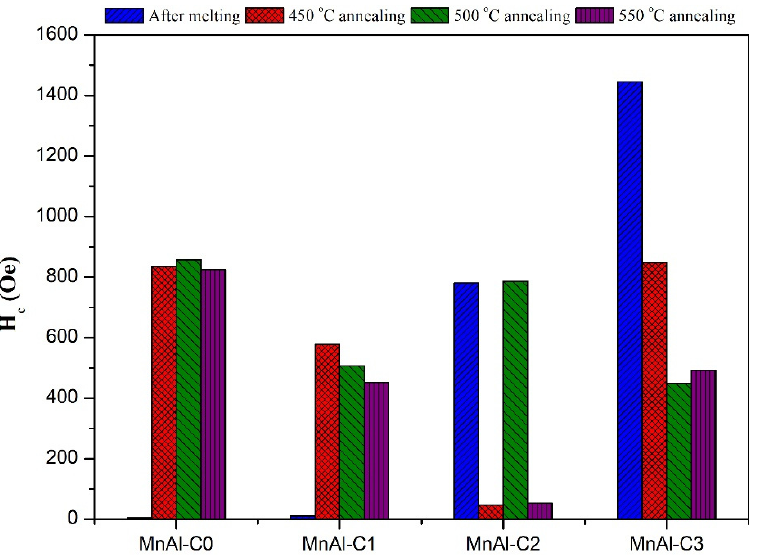
Figure 3. Hysteresis loops of (Mn 55 Al 45 ) 100-x C x powders; ( a ) MnAl–C0 (x = 0), ( b ) MnAl–C1 (x = 1), ( c ) MnAl–C2 (x = 2), and ( d ) MnAl–C3 (x = 3) after melting and annealing at 450, 500, and 550 °C for 20 min under argon atmosphere.